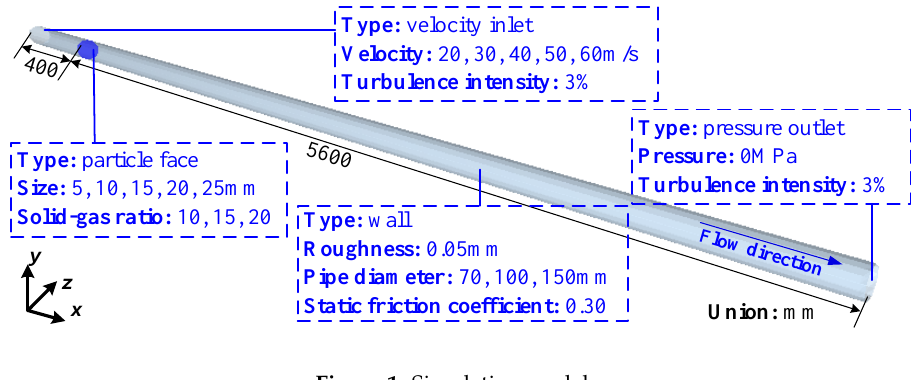
Figure 1. Simulation model.